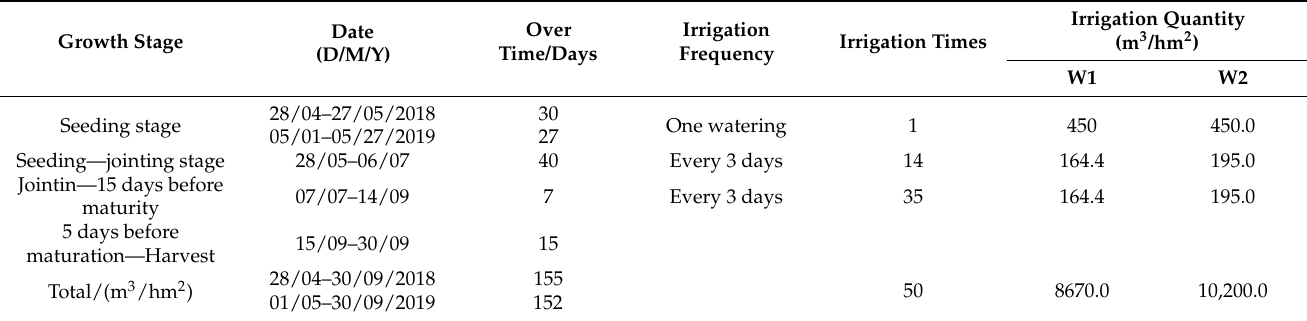
Table 1. Drip irrigation cycle and irrigation amount under membrane.